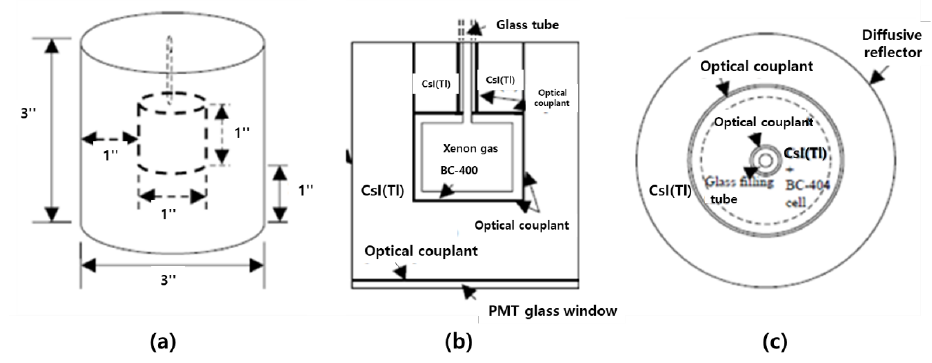
Figure 20. Geometric structure of the ARSA system: ( a ) Detector size; ( b ) Side; ( c ) Top [53].